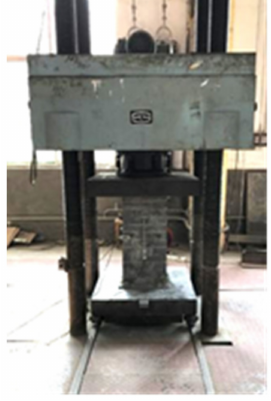
Figure 3. Loading